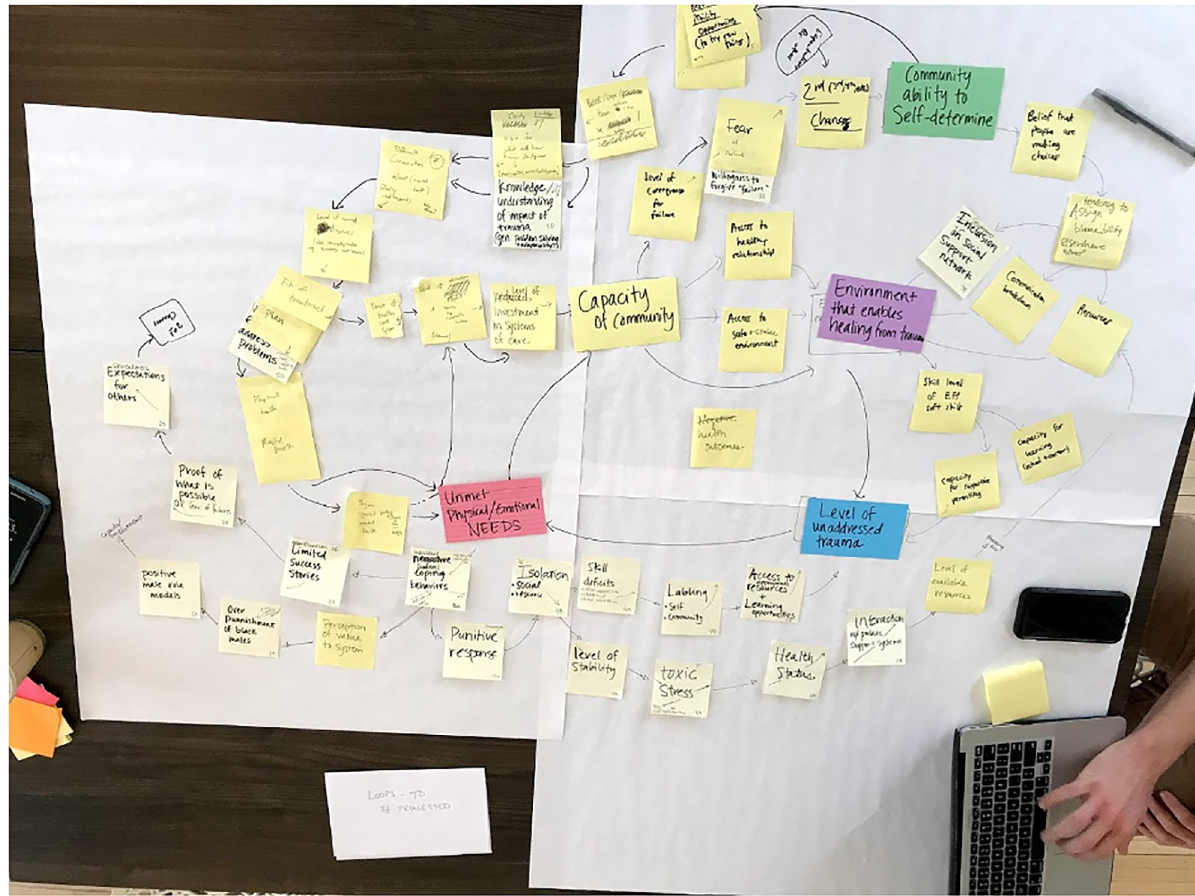
Fig 2. A rough draft of a working